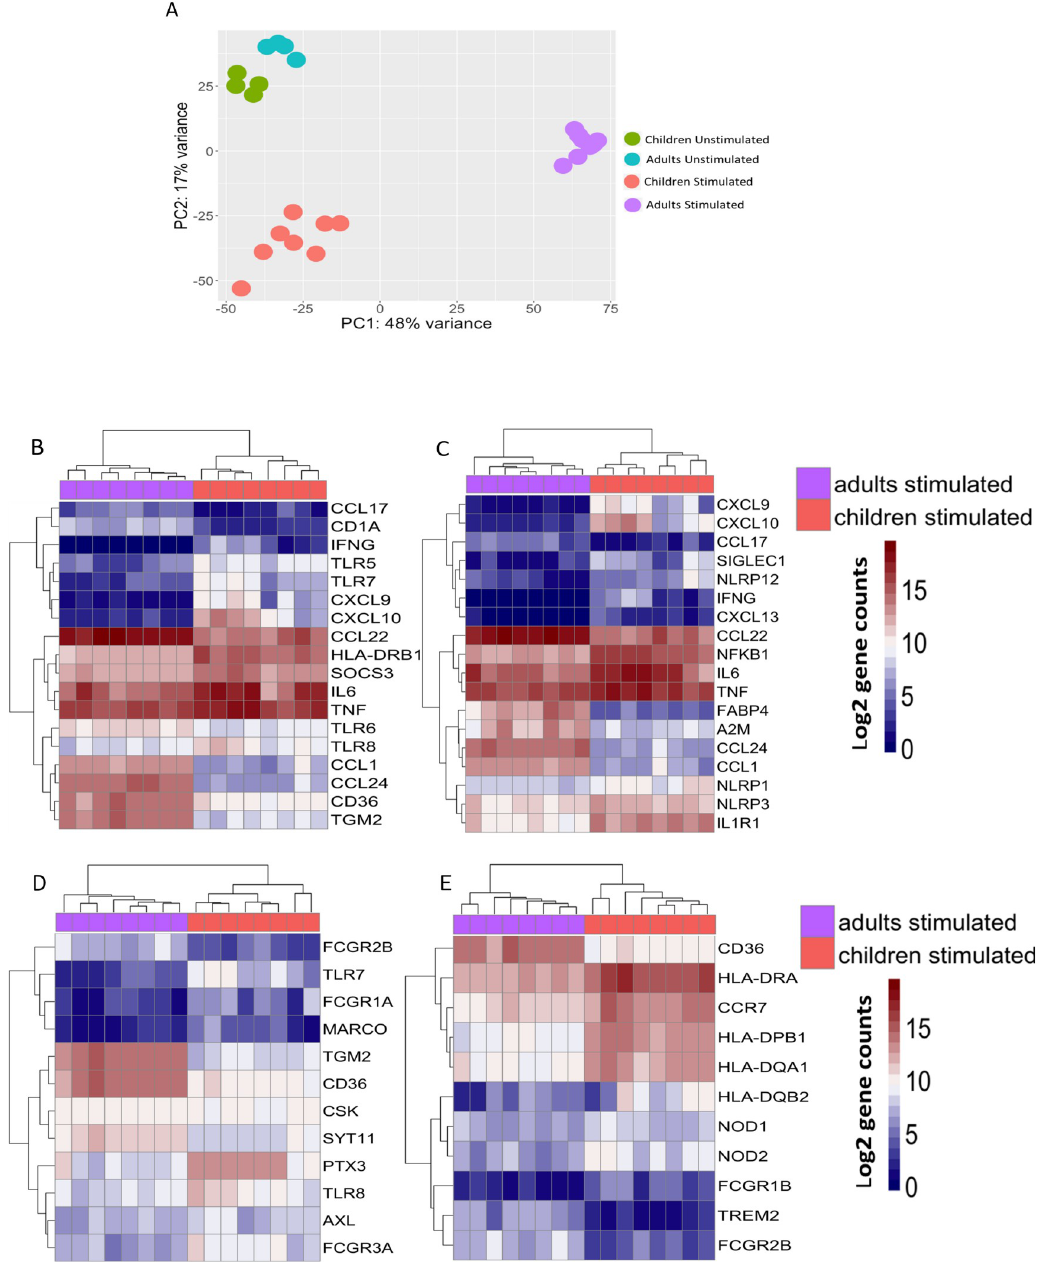
Fig 3. RNA-seq analysis of monocytes after Pf -iRBC stimulation reveals a regulatory signature in Malian adults that is distinct from children. Monocytes isolated from PBMCs of Malian children (n = 8) and adults (n = 8) were stimulated in vitro with Pf -iRBC lysate at a monocyte: Pf -iRBC ratio of 1:5 for 24 hours and then total RNA was isolated for sequencing. From separate subjects (n = 4 subjects in each age group), total RNA from unstimulated monocytes was also sequenced. (A) Principal- component analysis of log2-normalized gene counts across all samples. ( B-E) Heatmaps representing log2-normalized gene counts of Pf -iRBC stimulated monocytes from Malian children and adults. Each column represents one individual sample. Heatmaps represent gene sets with pre-specified functions: ( B ) M1/M2 monocyte/macrophage signature, ( C ) inflammation, ( D ) phagocytosis, and ( E ) antigen processing and presentation.